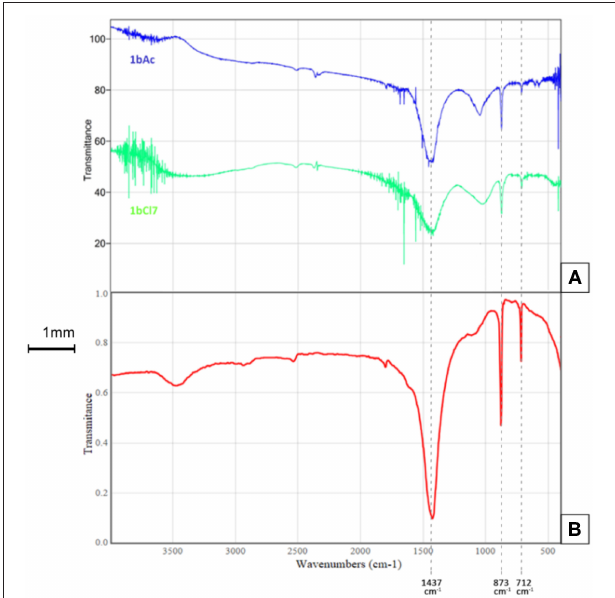
FIGURE 2 | FTIR spectra for (A) scraping from surface of sample 1bCl7 treated with L. sphaericus and CaCl 2 (green) and 1bAc7 treated with L. sphaericus and Ca(CH 3 COO) 2 (blue), (B) reference spectrum for calcite ( Calcium carbonate,